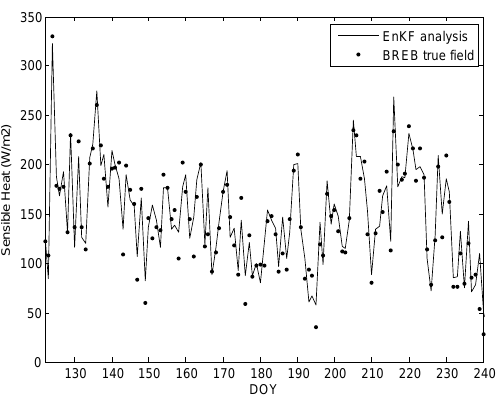
Fig. 5. Aerodynamic roughness height inversely tracked via